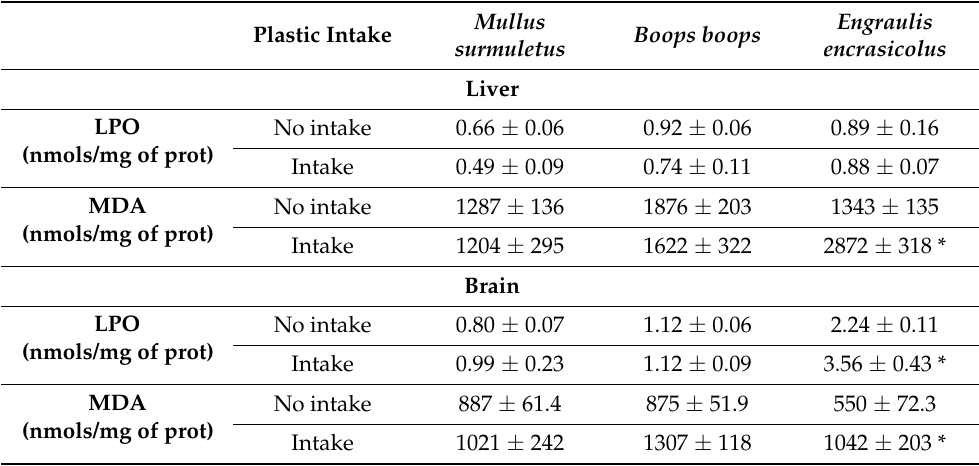
Table 4. Oxidative damage in the liver and in the brain in three fish species. Mullus Boops boops Plastic Intake